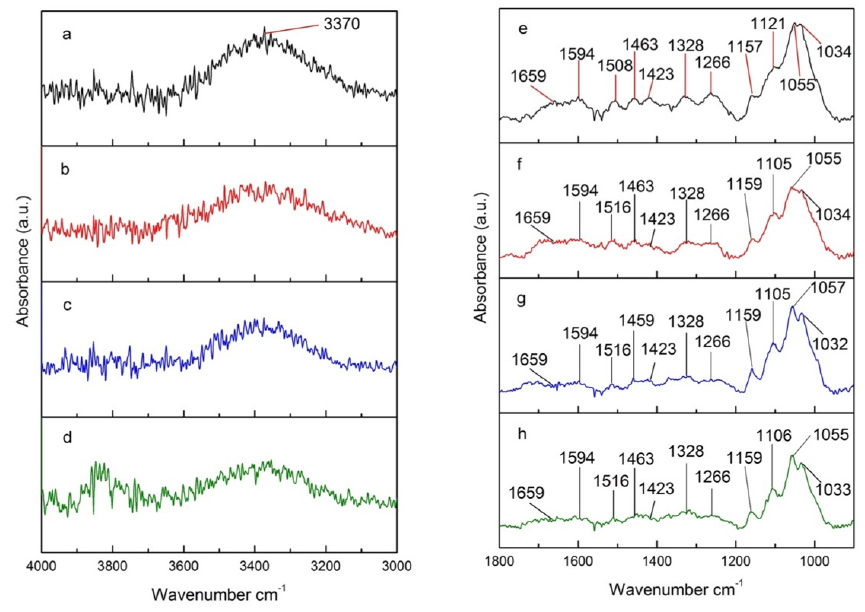
Figure 9. 4000–3000 cm −1 section of FTIR spectra of ( a ) untreated poplar and poplar treated under ( b ) N 2 , ( c ) water vapor, and ( d ) air; 1800–900 cm −1 section of FTIR spectra of ( e ) untreated poplar and poplar treated under ( f ) N 2 , ( g ) water vapor, and ( h ) air.